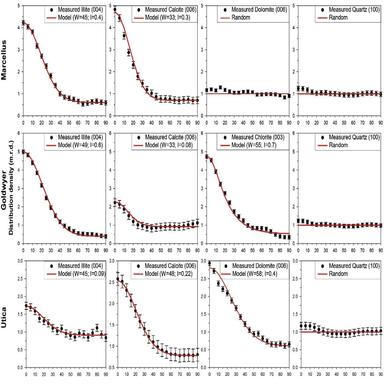
Comparison between measured and modeled distribution of the mineral basal planes plotted as distribution density against polar angle α. Model parameters full-width-at-half-maximum (W) and intensity (I) are reported in the legend.